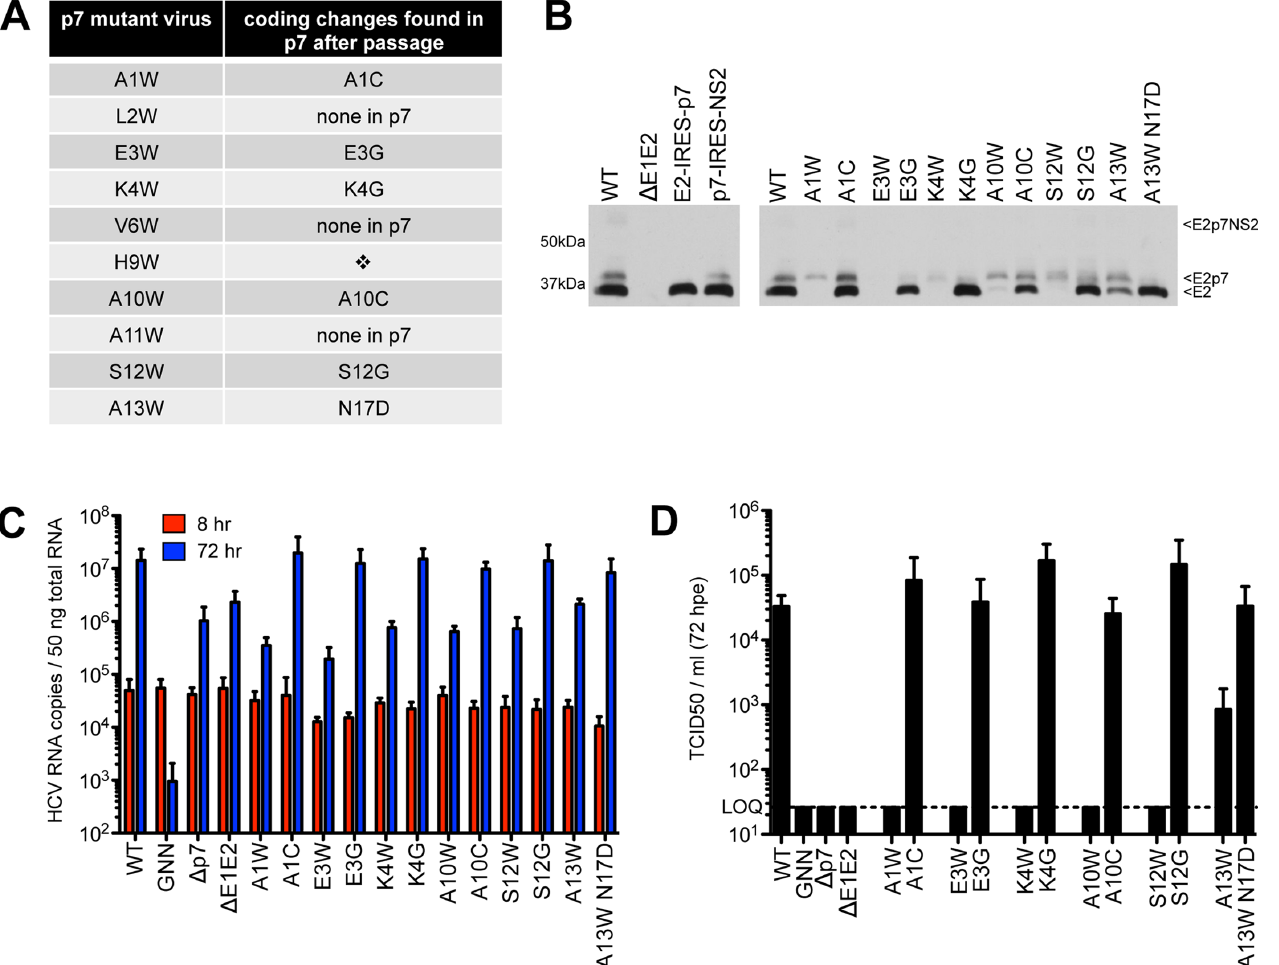
Fig 4. Passage of deleterious N-terminal mutants identifies second site pseudo-revertants. A) Coding changes identified within p7 by sequencing after passage of original p7 mutant genomes in Huh-7.5 cells. No virus was obtained after passage of H9W (indicated by the diamond). B) Western blot analyses detecting HCV E2 antigen. Left panel: J6/JFH WT-, Δ E1E2-, E2-IRES-p7- or p7-IRES-NS2-replicating Huh-7.5 cell lysates, used here to provide markers for E2p7NS2, E2p7, and E2 protein species. Right panel: Parallel western blot analysis comparing amounts of E2 relative to E2p7 between J6/JFH WT, original p7 mutant genomes and genomes harboring mutations identified after passage. C) HCV RNA levels in Huh-7.5 cells determined 8 and 72 hpe showing all p7 mutants (original and those harboring mutations identified after passage re-engineered into J6/JFH p7) replicate efficiently. D) Infectious virus in the supernatants quantified by limiting dilution assay on na ï ve Huh-7.5 cells demonstrating rescue of infectivity by mutations identified after passage re- engineered into the J6/JFH